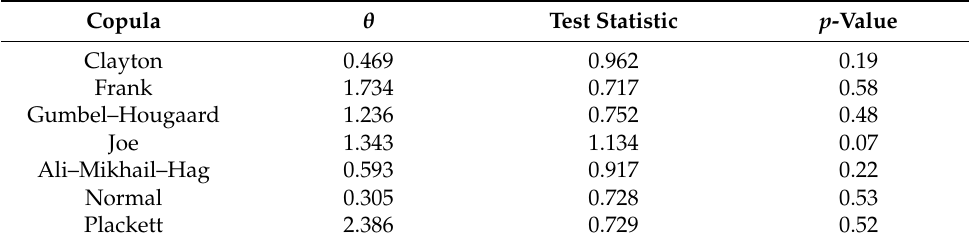
Table 4. Results of goodness of fit of copula functions.